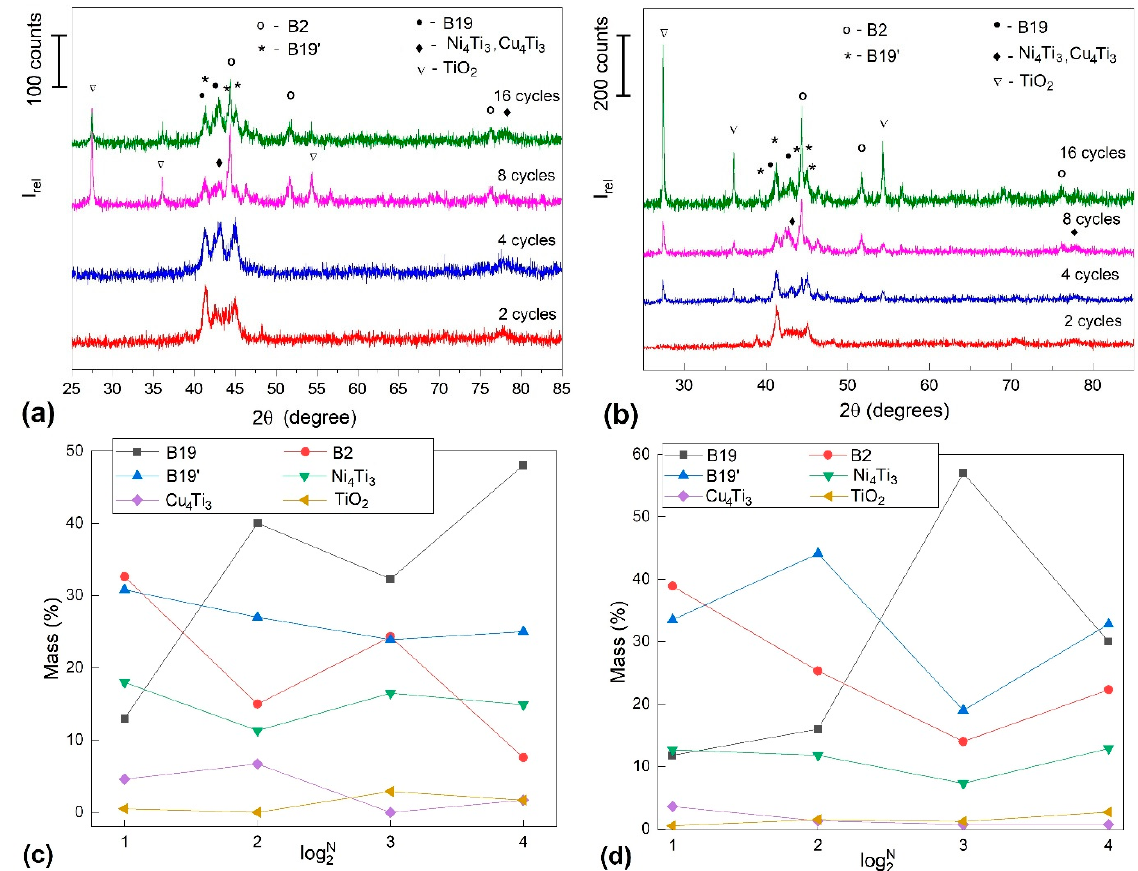
Figure 9. XRD patterns of specimens trained for N cycles by FR-SME : ( a ) on convex surfaces; ( b ) on concave surfaces; ( c ) semi-quantitative analysis for convex surfaces; ( d ) semi-quantitative analysis for concave surfaces.